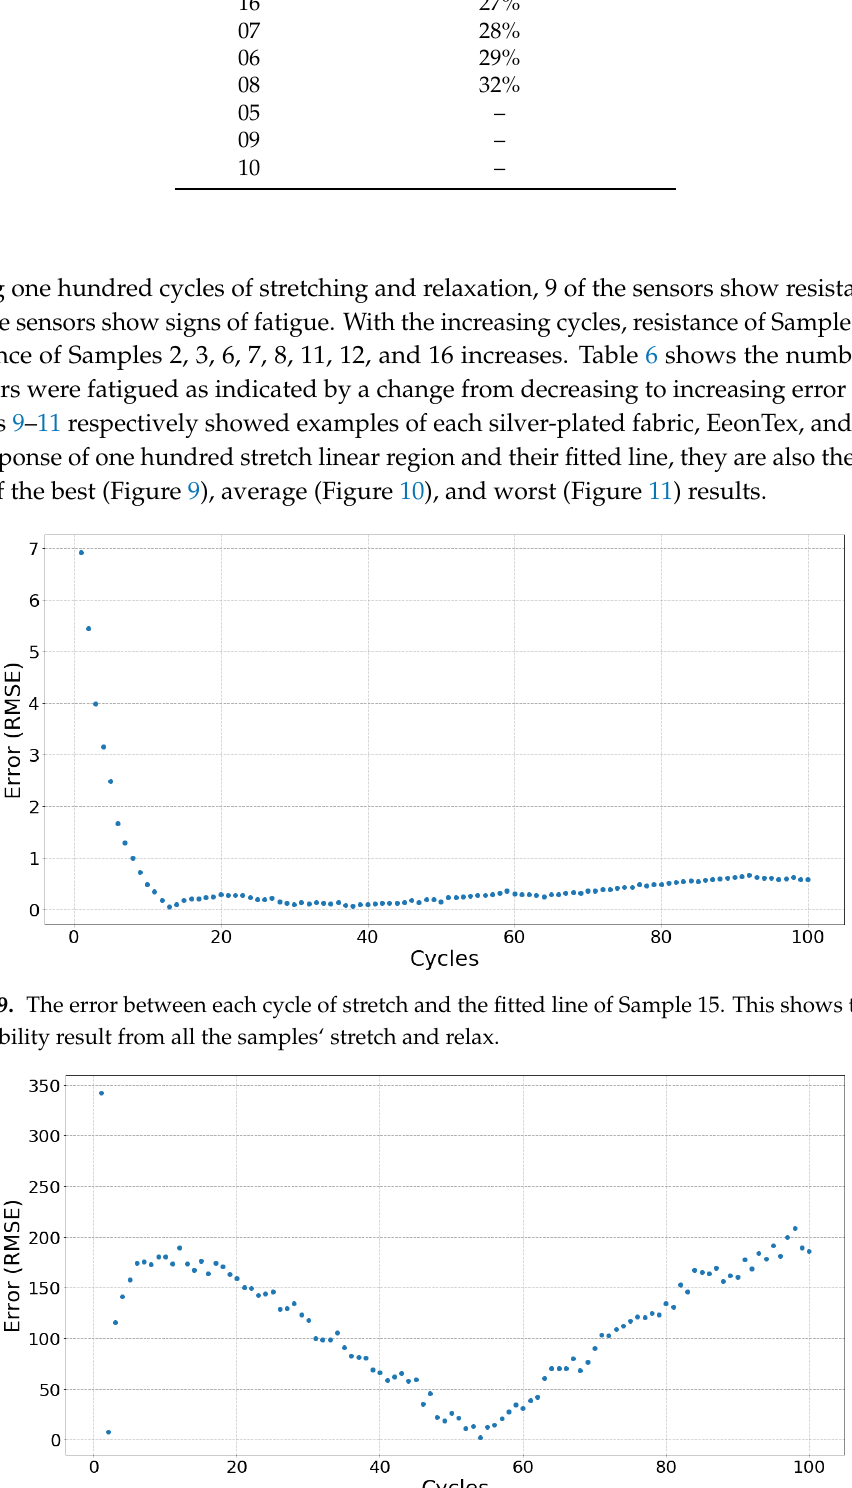
Figure 10. The error between each cycle of relaxation and the fitted line of Sample 01 (EeonTex). This plot shows the typical repeatability result from all the samples‘ stretch and relax. Most of the samples showed fatigue after 50 cycles of